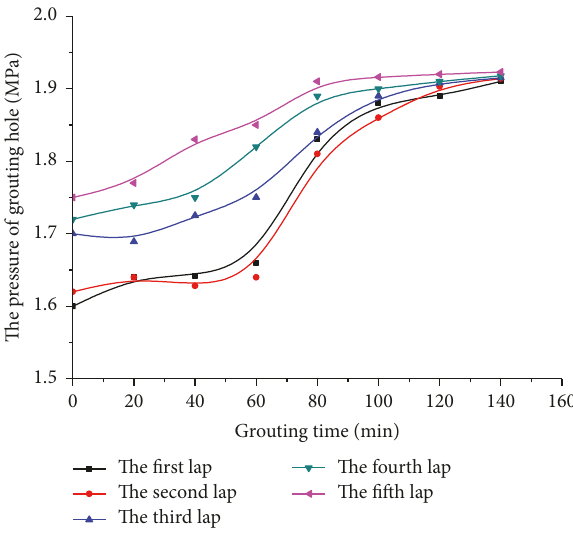
Figure 18: The layout of grouting hole.